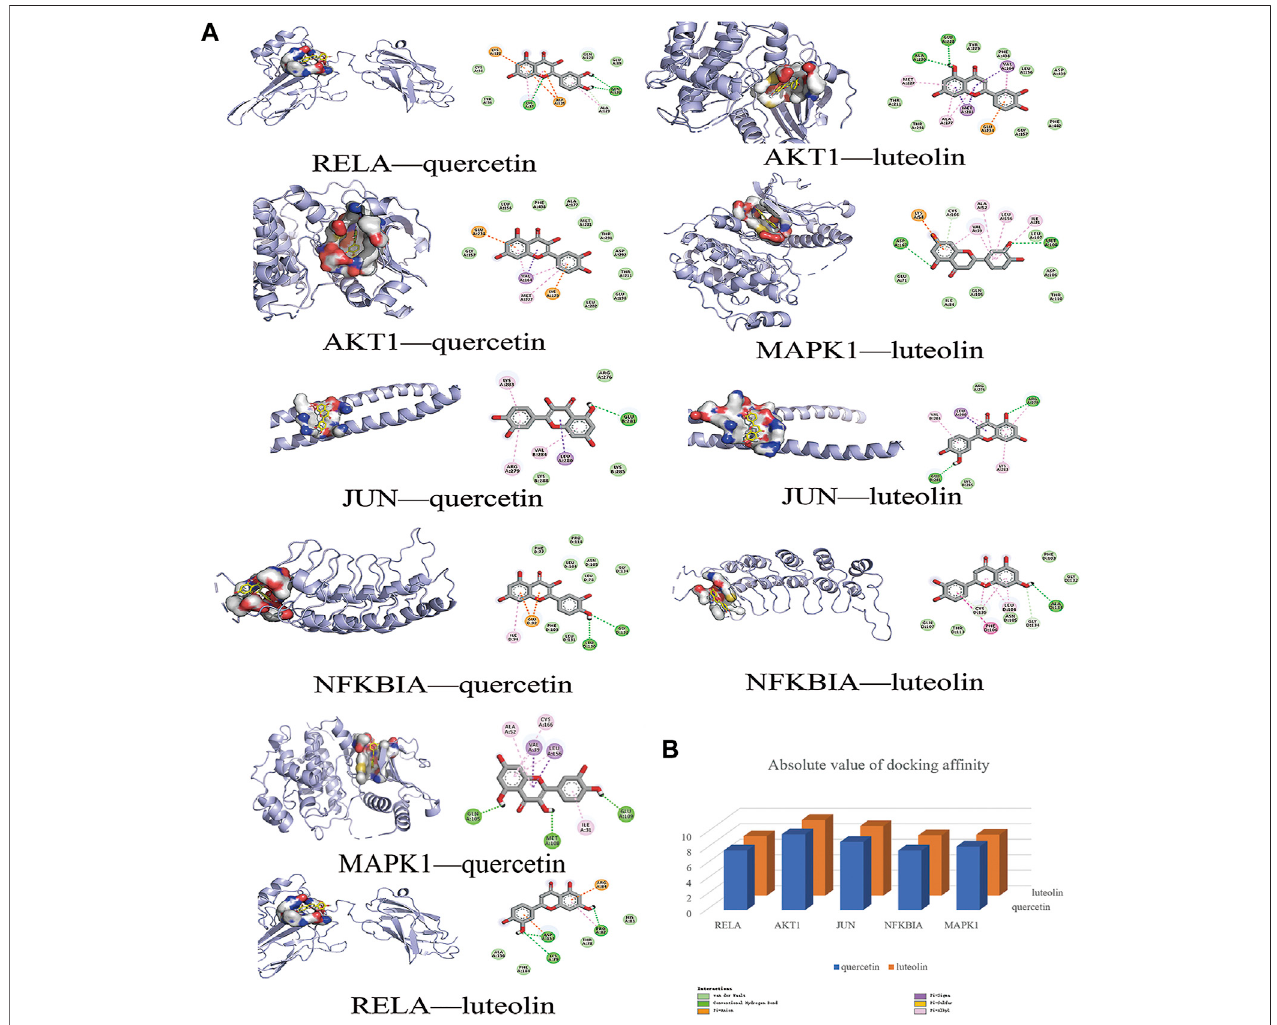
FIGURE6| Moleculardocking models ofmainchemical compounds binding topotentialtargets. (A) Moleculardocking models ofmain chemicalcompounds, (B) Absolute value of docking af fi nity.